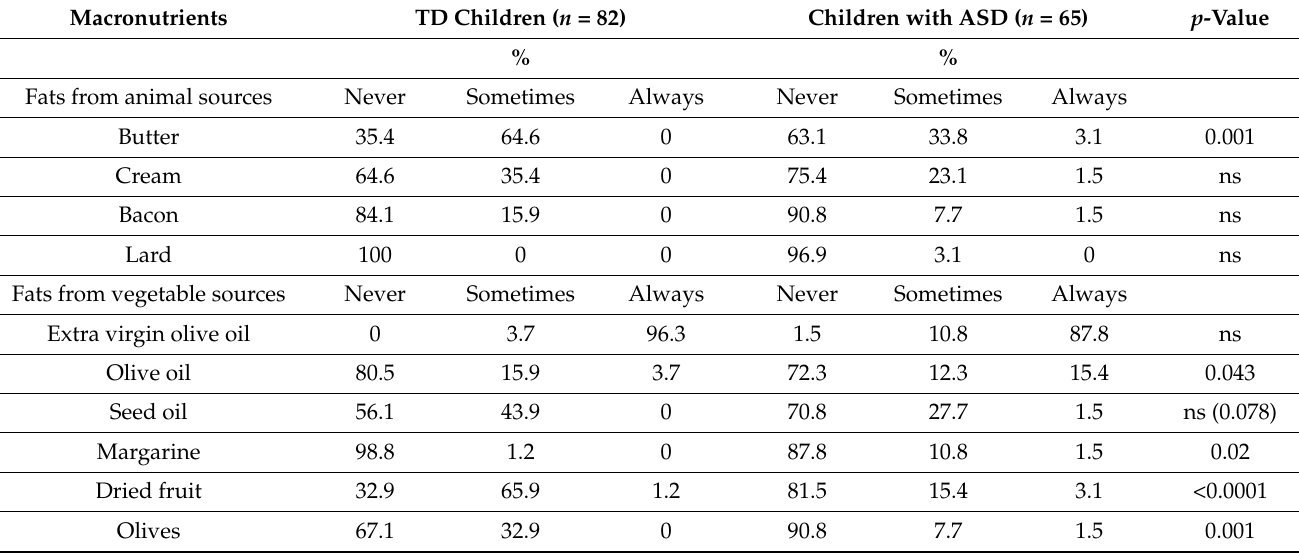
Table 5. Comparison of the rates of annual intake of animal and vegetable fats in each group between children with ASD and typically developing children.